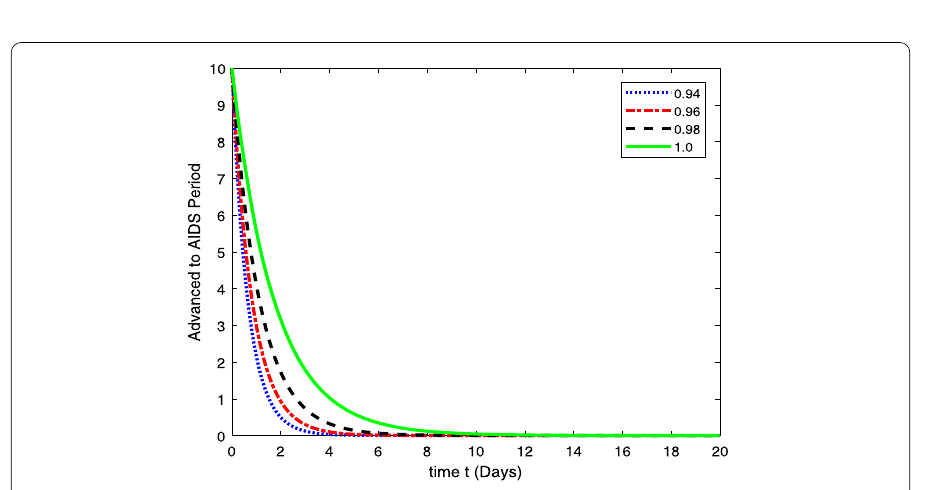
Figure 3 The infected class I ( t ) for α 1 = 1,0.98,0.96,0.94 and h = 0.09